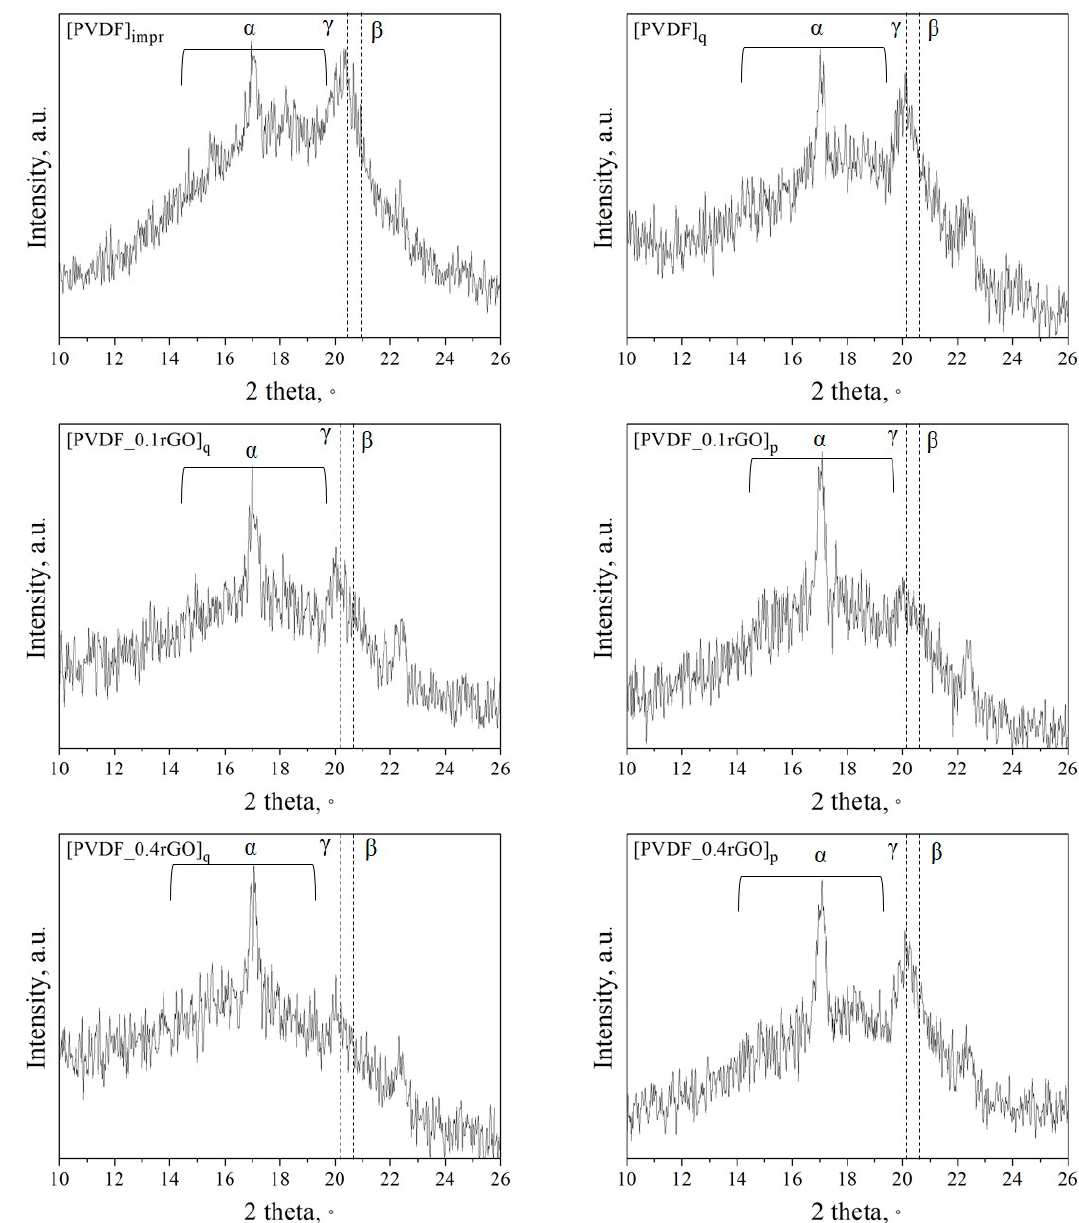
Figure 8. X-ray di ff raction (XRD) of the imprinted and quenched PVDF micropillars and those filled Figure 8. X-ray diffraction (XRD) of the imprinted and quenched PVDF micropillars and those filled with 0.1 wt % and 0.4 wt % with 0.1 wt % and 0.4 wt % rGO.